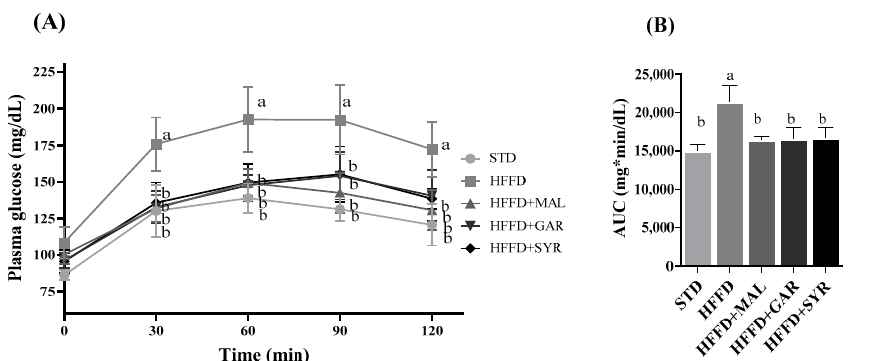
Figure 3. E ff ect of di ff erent varieties of grape pomace on glucose tolerance in rats fed a high-fat high- fructose diet. ( A ) Postprandial blood glucose levels and ( B ) area under the curve (AUC) measured between 0 and 120 min after glucose load. Data are reported as means ± SE for eight animals per group. Statistically signi fi cant di ff erences were determined by ANOVA, followed by Tukey’s test ( p < 0.05). STD; standard diet, HFFD; high-fat high-fructose diet, MAL; Malbec, GAR; Garnacha, SYR; Syrah. PCA multivariate analyses were performed to provide an overview of the physiolog- ical modi fi cations caused by grape pomace supplementation. In an initial approach, the